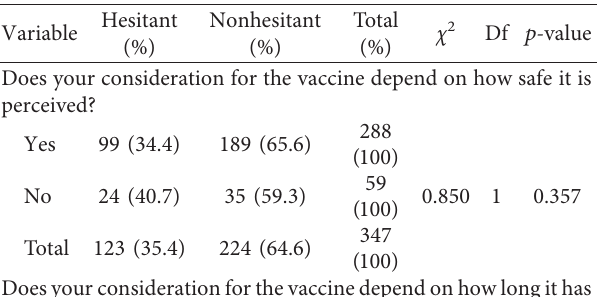
Table 5: Vaccine-specific perception factors and vaccine hesitancy among HCWs in Imo State, Nigeria.